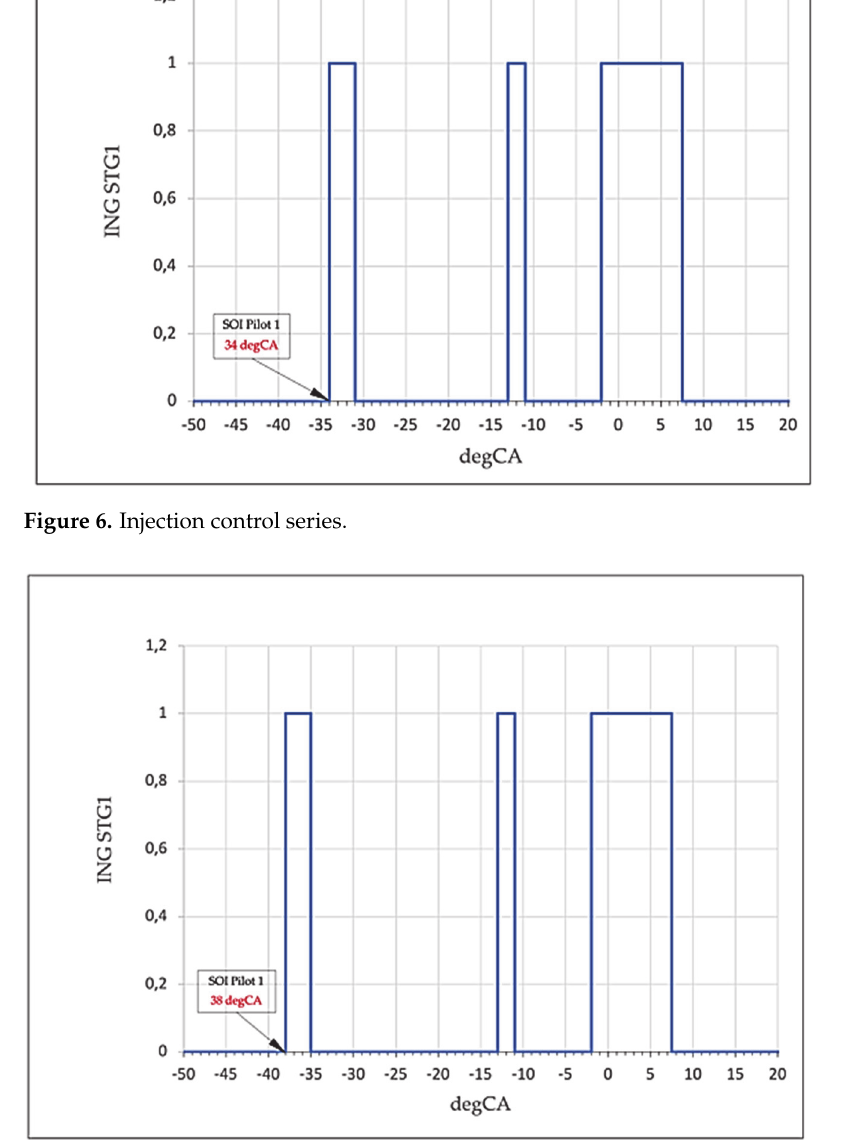
Figure 7. Injection control after modifications.